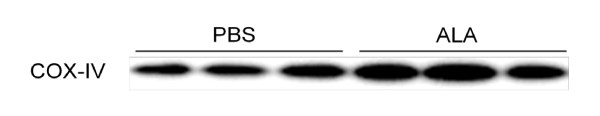
Western blot analysis of the mouse liver mitochondrial fraction. Ten micrograms of liver mitochondria, obtained as described in the Material and Methods section, were separated by 15% SDS-PAGE and then electrotransferred on to a PVDF membrane and Western blot analysis were performed using COX IV-1 antibody. The average COX IV expression level in the ALA administered group was 1.6-fold higher than that of the control group.